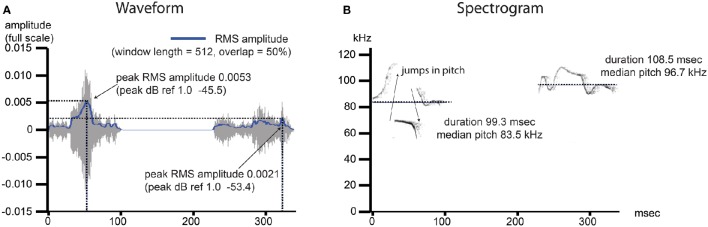
USV features under investigation include commonly measured features from the time and frequency domain. Example image shows two pup isolation-induced ultrasonic calls. (A) Waveform: the time domain data for the noise- and frequency-filtered calls. A root mean squared (RMS) amplitude envelope is determined for each calls, and the peak power from this envelope (power = amplitude2) is determined and reported as dB ref 1.0. The average of this measurement is determined over all calls, per recording, as well as the variability in this measurement, reported as the standard deviation divided by the mean (coefficient of variation). (B) Spectogram: the frequency domain data for the noise- and frequency-filtered calls. The presence of a pitch jump is determined by an instantaneous change in the frequency of maximum power ≥10 kHz, and the fraction of all calls containing at least 1 such jump was computed. The median value of the pitch (kHz) as well as the duration (ms) were determined, and both the average over all calls by recording as well as the coefficients of variation (sd/mean) representing the variability in these measurements over all calls, were computed.